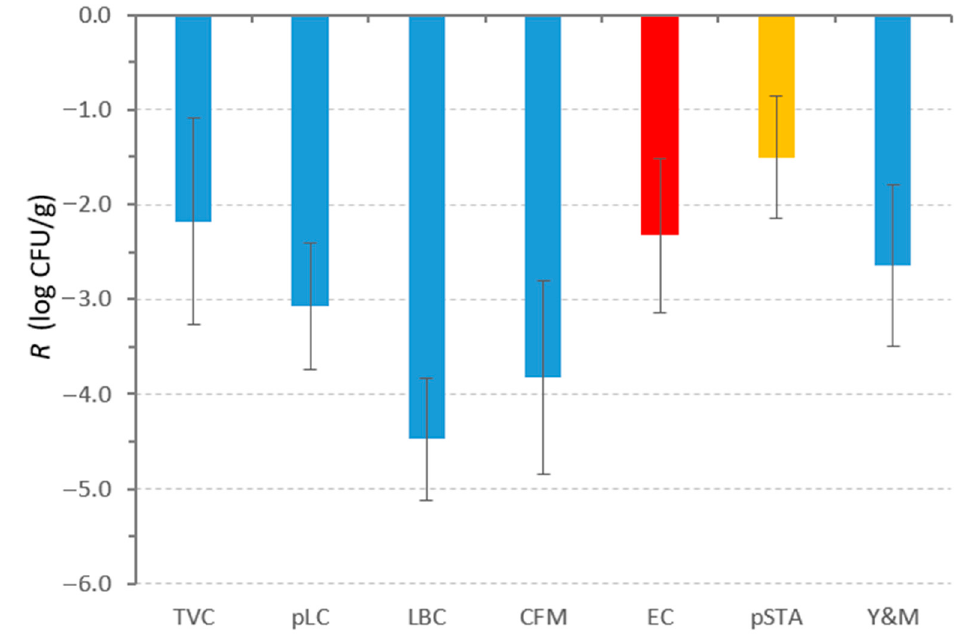
Figure 6. Reductions in the microbial indicators during the steaming and stretching process. The values of pLC and LBC represent only 3 replications.